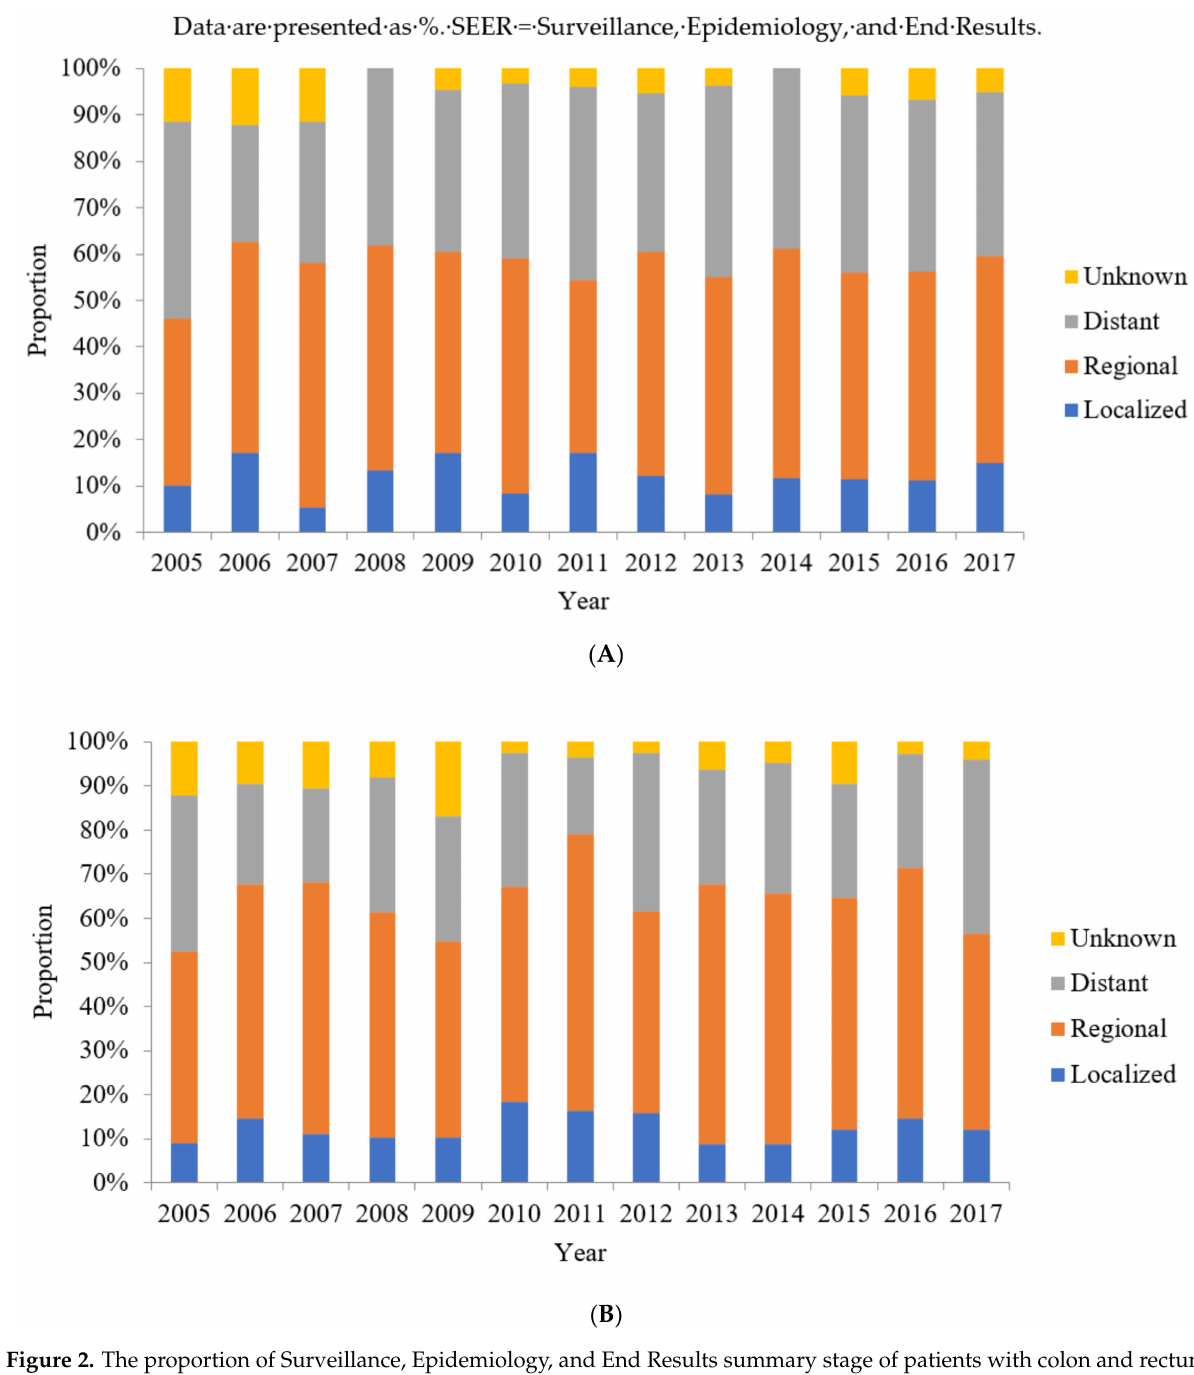
Figure 2. The proportion of Surveillance, Epidemiology, and End Results summary stage of patients with colon and rectum signet-ring cell carcinoma between 2005 and 2017. ( A ) The proportion of Surveillance, Epidemiology, and End Results summary stage of patients with colon signet-ring cell carcinoma between 2005 and 2017. ( B ) The proportion of Surveillance, Epidemiology, and End Results summary stage of patients with rectum signet-ring cell carcinoma between 2005 and